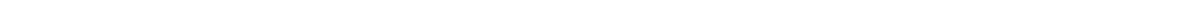
Fig. 4 SyCyRs for IL-6 (SyCyR(IL-6)) simulate IL-6/IL-11-induced signal transduction. a Schematic illustration of IL-6 SyCyR and GFP-GFP. G VHH -gp130: G VHH fused to 13 aa of the ECD, TMD, and ICD of gp130. b JAK and TYK activation in Ba/F3-SyCyR(IL-6) cells stimulated with supernatants containing 100 ng/ml of indicated synthetic ligands or HIL-6 (100 ng/ml) for 20 min. Equal amounts of total protein (50 μ g/lane) were analyzed for phospho-JAK2/ TYK2/JAK1 and JAK2/TYK2/JAK1. Western blot data show one representative experiment out of three. c STAT3 and ERK1/2 activation in Ba/F3-SyCyR (IL-6) cells stimulated with 4% conditioned supernatant containing mCherry, 2xmCherry or conditioned supernatants containing 100 ng/ml of indicated synthetic ligands for 60 min. Stimulation with HIL-6 (10 ng/ml) for 15 min was used as control. Equal amounts of total protein (50 μ g/lane) were analyzed for phospho-STAT3/ERK1/2 and STAT3/ERK1/2. One representative experiment out of two is shown. d Proliferation of Ba/F3-SyCyR(IL-6) and Ba/F3- gp130 cells with 3xGFP and HIL-6 cultured in the presence of ligands (0.1 to 1600 ng/ml). One representative experiment out of fi ve is shown. Results are mean ± s.d. of three replicates. e Ba/F3-SyCyR(IL-6) cells were stimulated with 3xGFP (100 ng/ml) and HIL-6 (25 ng/ml) for 0-480 min. Total protein (50 μ g/lane) were analyzed for phospho-STAT3 and STAT3, SOCS3, and β -actin. Western blot data show one representative experiment out of three. f Western blot of mouse liver lysates and mouse serum prepared 24 h following hydrodynamic transfection of PBS, pcDNA3.1-3xGFP (1.28 µ g) and/or pcDNA3.1-G VHH -gp130 (2.3 µ g) plasmid DNA. Total proteins (50 μ g/lane) were analyzed for phospho-STAT3, STAT3, GFP, and γ -tubulin. Serum volumes from 0.25 – 1 µ l were analyzed for GFP; n = 3 animals/group. g Ratio of relative density of pSTAT3 and STAT3 liver expression as determined in f ; Results are mean ± s.e.m. of three animals/group. Signi fi cance of difference (one-way ANOVA): * p < 0.05. h qRT-PCR of Saa1 mRNA 24 h after hydrodynamic transfection of 1.28 µ g pcDNA3.1-3xGFP and/or 2.3 µ g pcDNA3.1-G VHH -gp130 plasmid and normalized using the housekeeper mRNA Gapdh and the ΔΔ CT method; Results are mean ± s.e.m. of six animals/group. Signi fi cance of difference (one-way ANOVA): * p <